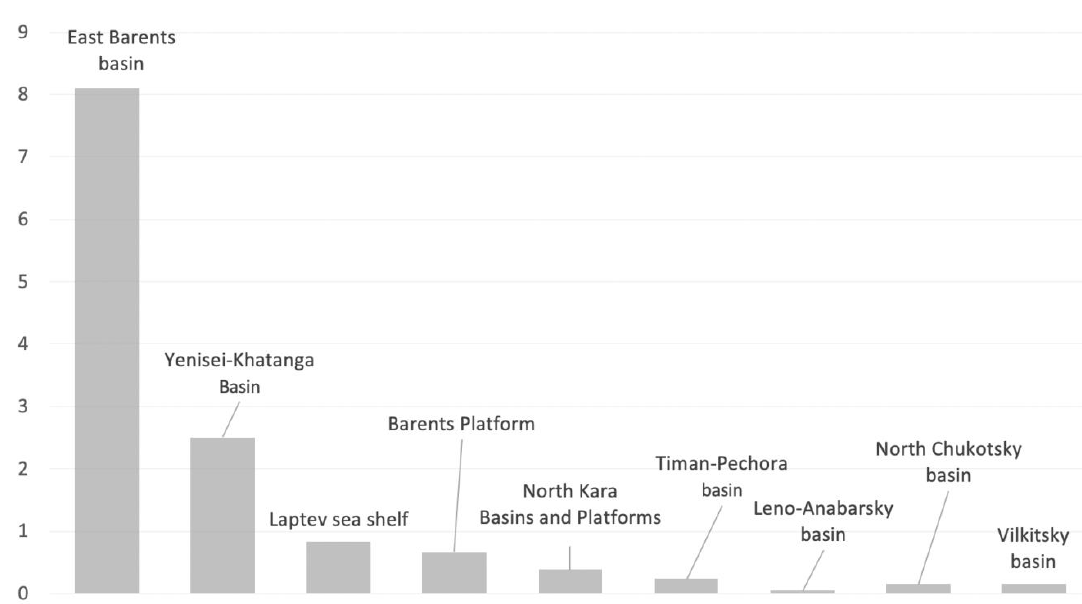
Figure 12. Estimation of oil resources in the Arctic basins of Russia (according to the United States Geological Survey (USGS) data [54]), billion tons.